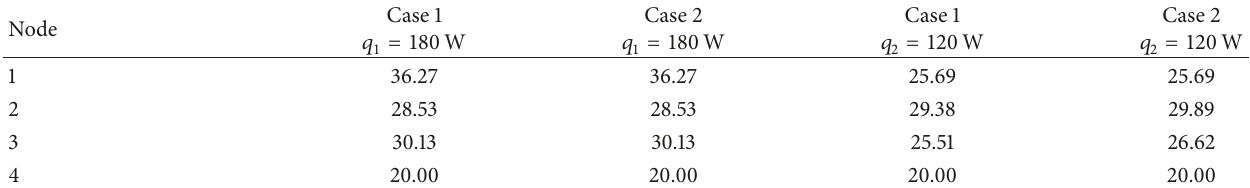
Table 11: Temperature results ( ∘